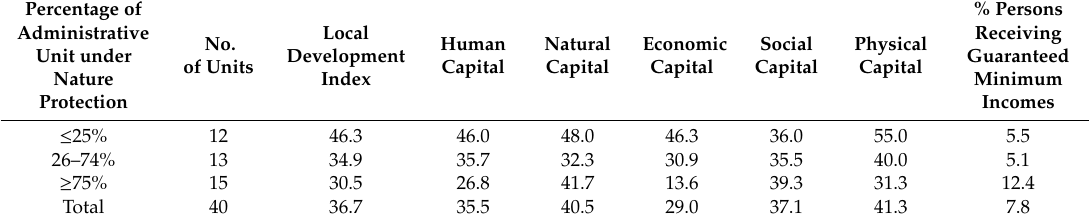
Table 2. The profile of communities living in protected areas compared to the available resources.